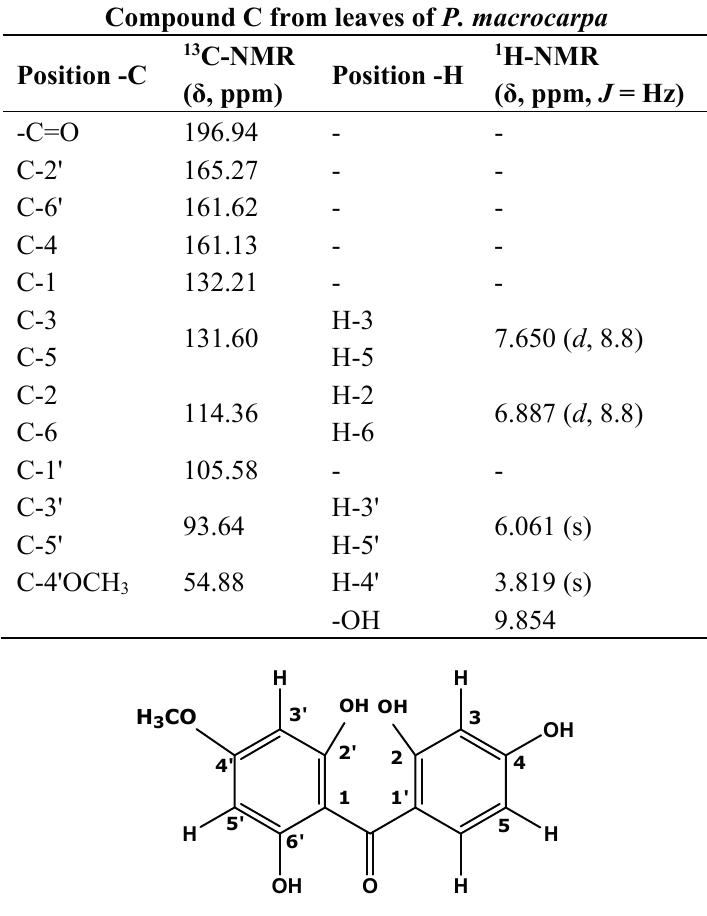
Figure 1. Molecular structure of